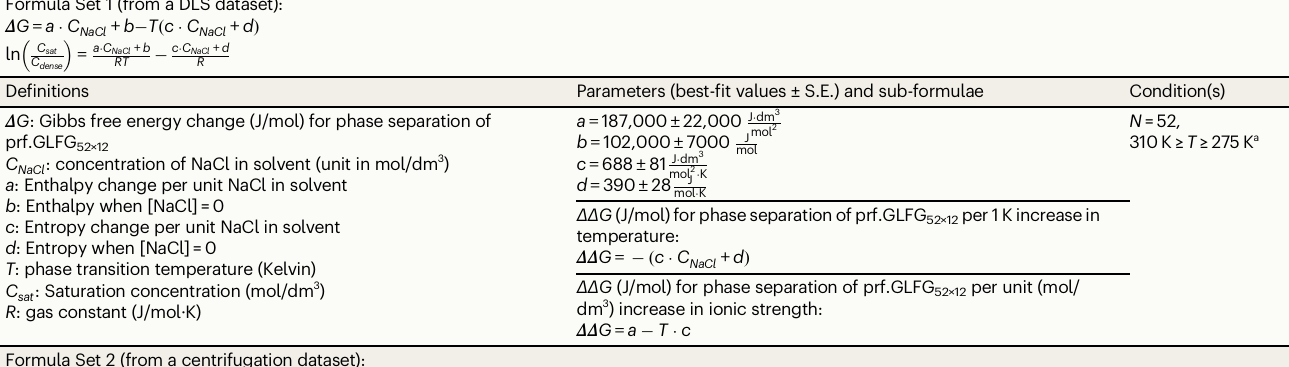
Parameters (best- fi t values ± S.E.) and sub-formulae Condition(s)